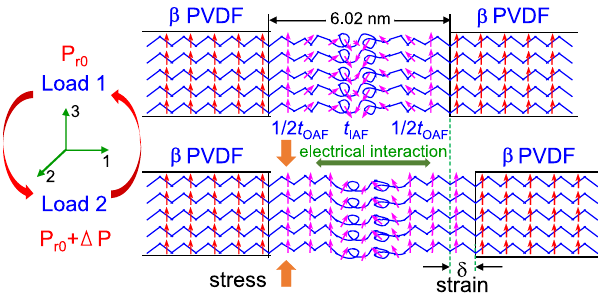
Fig. 4 Direct piezoelectric effect. Schematic representation of stress- induced direct piezoelectric